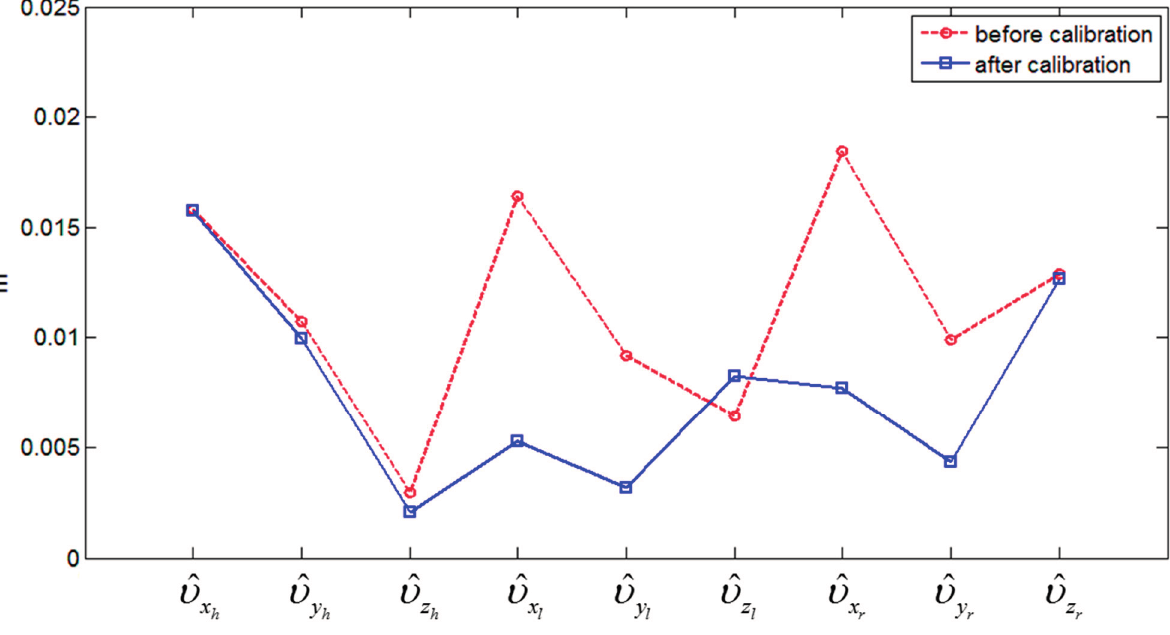
Figure 17. Estimated mean residuals before and after the constrained